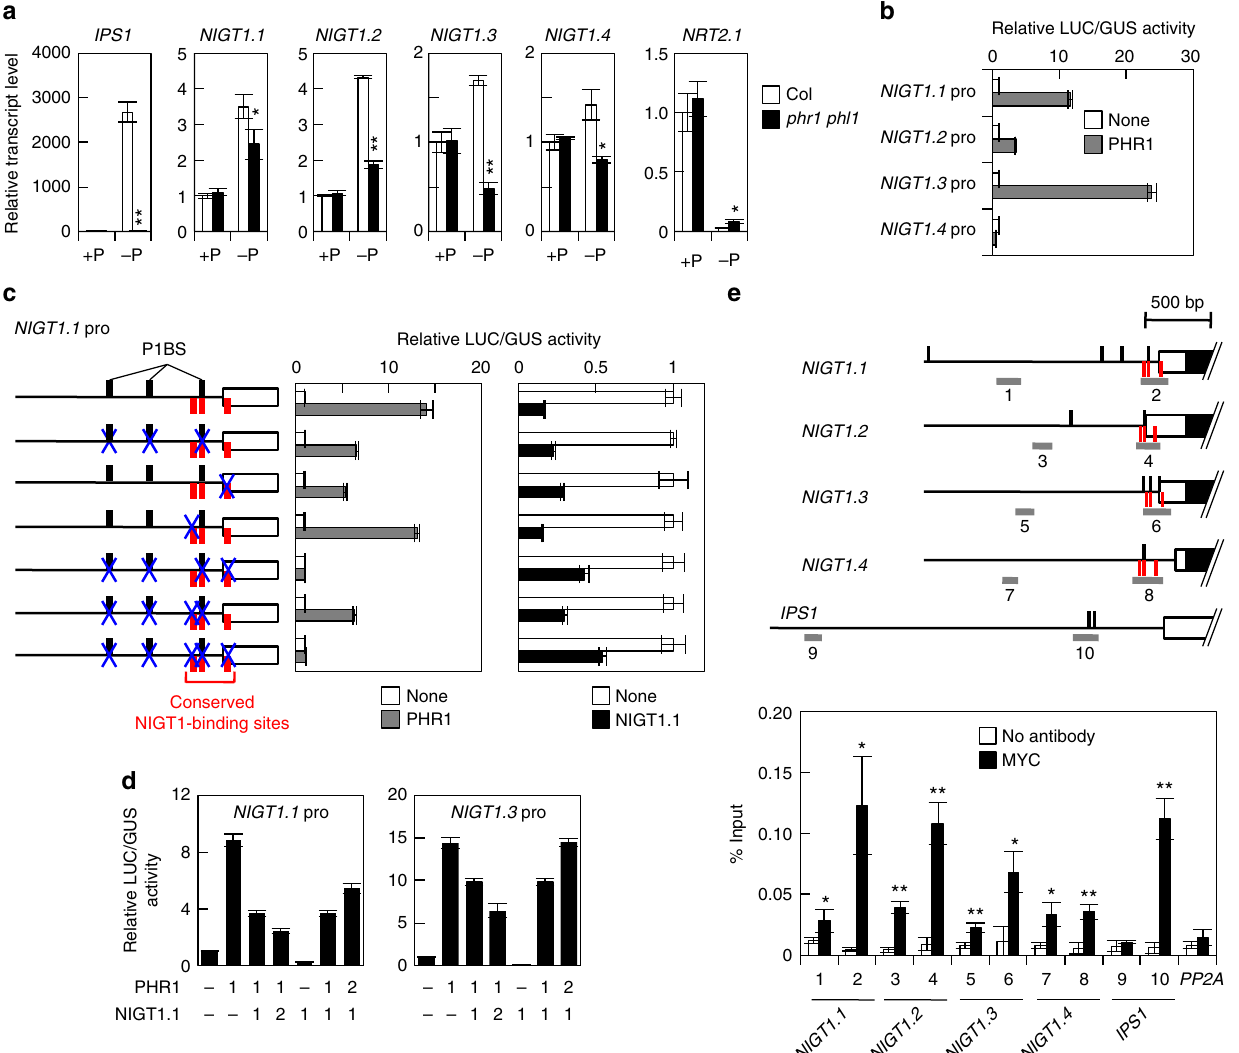
Fig. 7 PHR1-dependent activation of NIGT1-clade genes. a Effects of P starvation on the expression of NIGT1-clade genes and NRT2 . 1 in roots of Arabidopsis Col and phr1 phl1 double mutant. Roots of Arabidopsis plants that were grown hydroponically under P-suf fi cient ( + P) or P-starved ( − P) conditions for 5 days were used for RT-qPCR analysis. IPS1 is a positive control for P starvation. Values are normalised with expression levels of PEX4 , and means of biological triplicates with s.d. are shown. * p < 0.05, ** p < 0.01 by two-tailed t -test compared with corresponding Col values. b Transactivation of NIGT1 promoters by PHR1. A reporter plasmid containing 1 kb promoter fragments of NIGT1 - clade genes fused to the LUC gene was co-transfected into protoplasts with the PHR1 expression vector or an empty vector (none) and the UBQ10-GUS plasmid. c Identi fi cation of sites mediating PHR1 regulation and autoregulation in the NIGT1 . 1 promoter. Transactivation of wild-type and mutated NIGT1 . 1 promoters by PHR1 and repression by NIGT1.1 were analysed by co-transfection assays. The horizontal line indicates the 1 kb NIGT1 . 1 promoter. Vertical black and red lines indicate the P1BS sequences and the conserved NIGT1 sites, respectively. Mutated sites are indicated with blue X. d Competitive regulation of the NIGT1-clade gene promoters by PHR1 and NIGT1. Expression vectors for PHR1 and NIGT1.1 were co-transfected into protoplasts at different ratios, together with the LUC reporter gene under the control of the NIGT1 . 1 or NIGT1 . 3 promoter. In b − d , relative LUC activity is given as mean ± s.d. of three biological replicates. e Binding of PHR1 to the NIGT1-clade gene